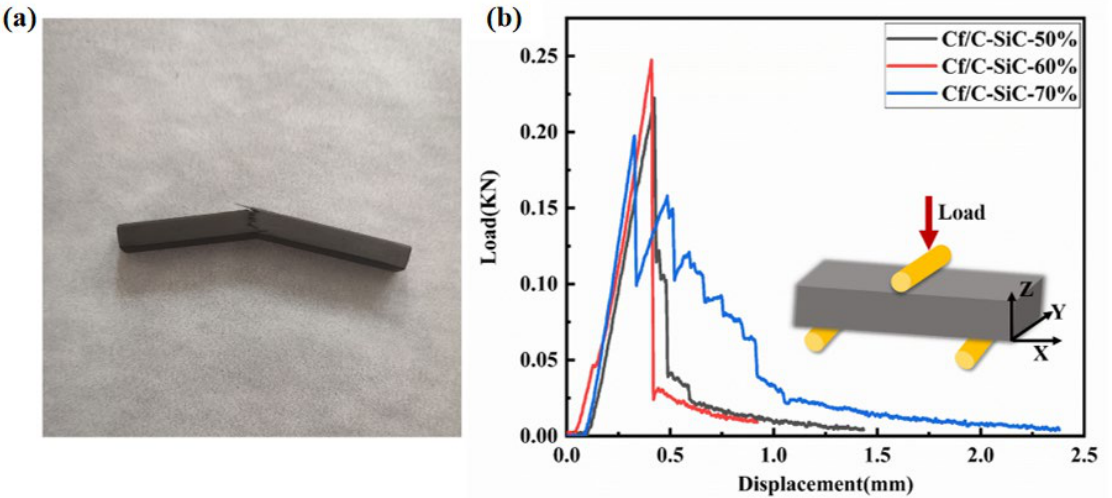
Figure 6. ( a ) Macromorphology of composites after three-point bending test; ( b ) the load–displacement curves of the Cf/C-SiC composites during the three-point bending test.